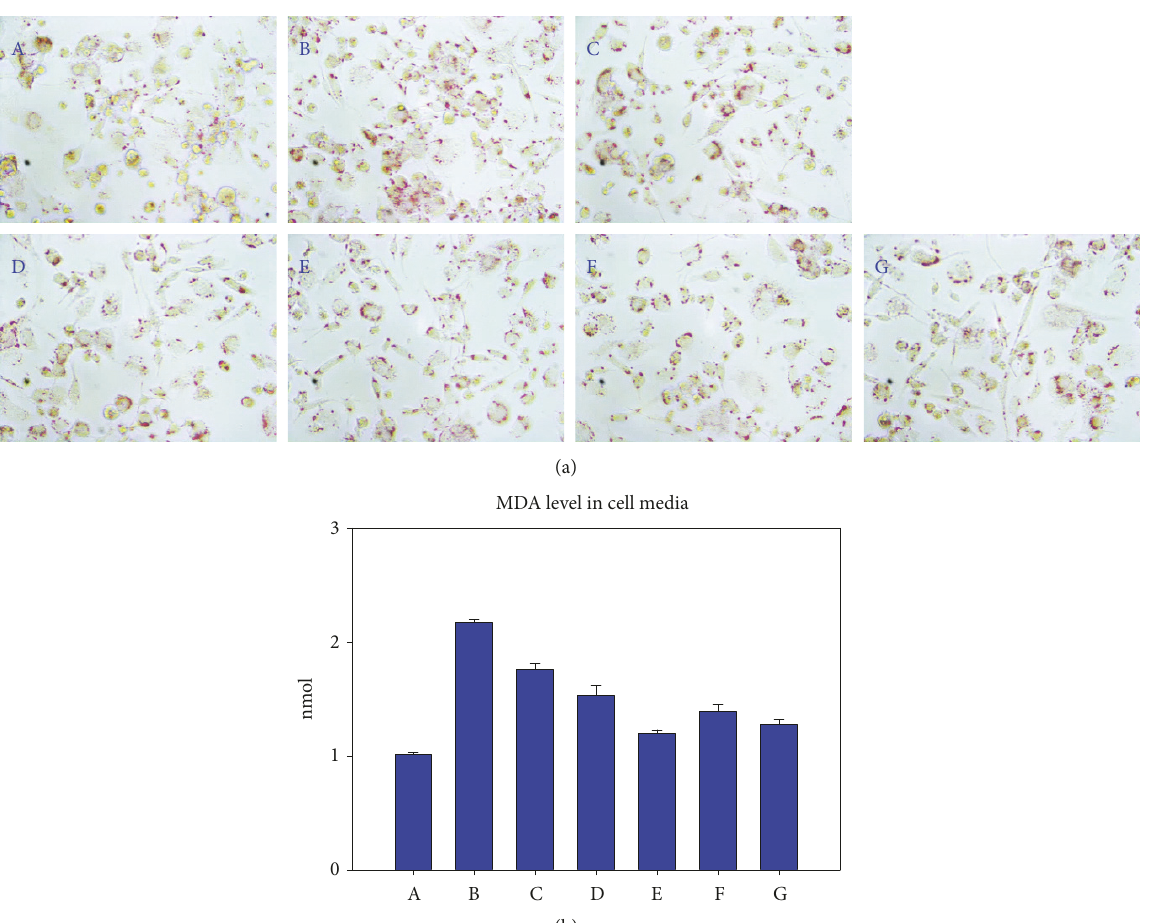
Figure 6: Antiatherogenic activity of PCO-rHDL or SCWA-rHDL under presence of oxLDL. Uptake of oxLDL into macrophages was visualized by oil red O staining. Photo A, blank control; photo B, oxLDL alone; photo C, oxLDL + rHDL; photo D, oxLDL + SCWA-rHDL (1:1); photo E, oxLDL + SCWA-rHDL (1:5); photo F, oxLDL + PCO-rHDL (1:1); photo G, oxLDL + PCO-rHDL